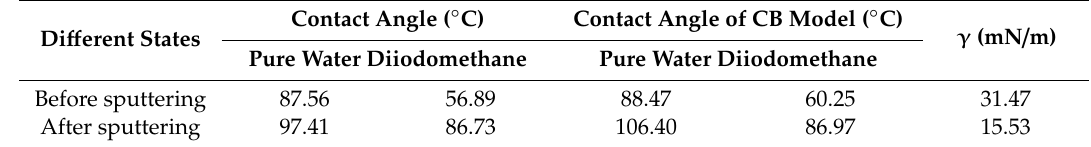
Table 4. The surface energy of the optical mold before and after being sputtered.